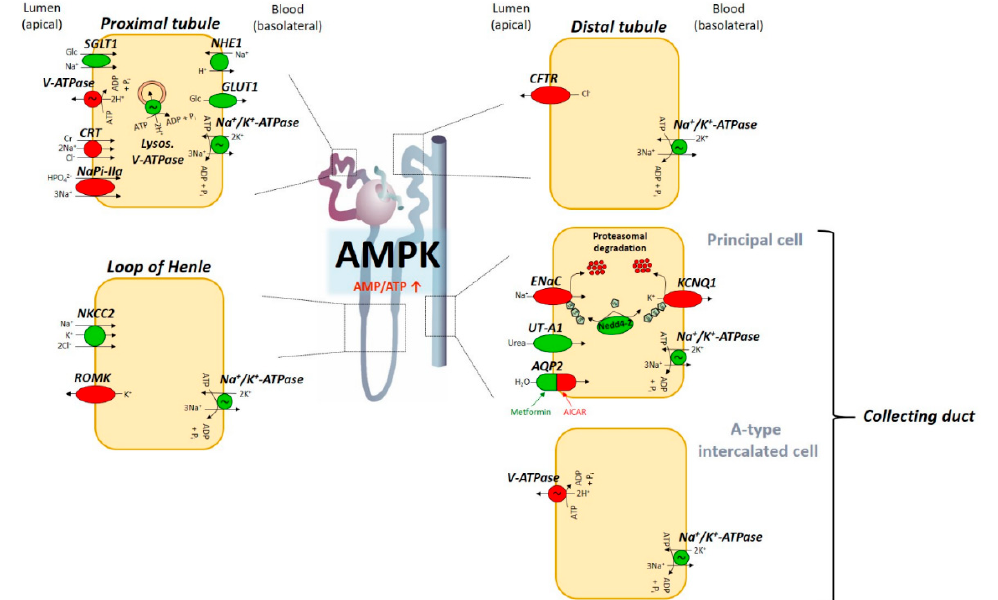
Figure 1 . Tentative model illustrating AMPK-dependent effects on renal transport along the nephron. Cellular energy depletion (e.g., during hypoxia) leads to an elevated AMP/ATP ratio and subsequent AMPK activation. AMPK in turn regulates a multitude of active and passive epithelial transport processes along the renal tubular system in order to maintain cellular energy homeostasis. Ion channels, transport proteins, and ATPases that are activated upon AMPK stimulation are depicted as green icons, whereas red coloring indicates AMPK-dependent inhibition (see text for details). AMP, 5’-adenosine monophosphate; AMPK, AMP-activated protein kinase; SGLT1, Na + -dependent glucose cotransporter 1; V-ATPase, vacuolar H + -ATPase; CRT, creatine transporter; NaPi-IIa, Na + -coupled phosphate transporter IIa; NHE1, Na + /H + exchanger isoform 1; GLUT1, glucose transporter 1; NKCC2, Na + -K + -2Cl − cotransporter; ROMK, renal outer medullary K + channel; CFTR, cystic fibrosis transmembrane conductance regulator; ENaC, epithelial Na + channel; KCNQ1, voltage-gated K + channel; Nedd4-2, neural precursor cell expressed developmentally downregulated protein 4-2; UT-A1, urea transporter A1; AQP2, aquaporin 2.